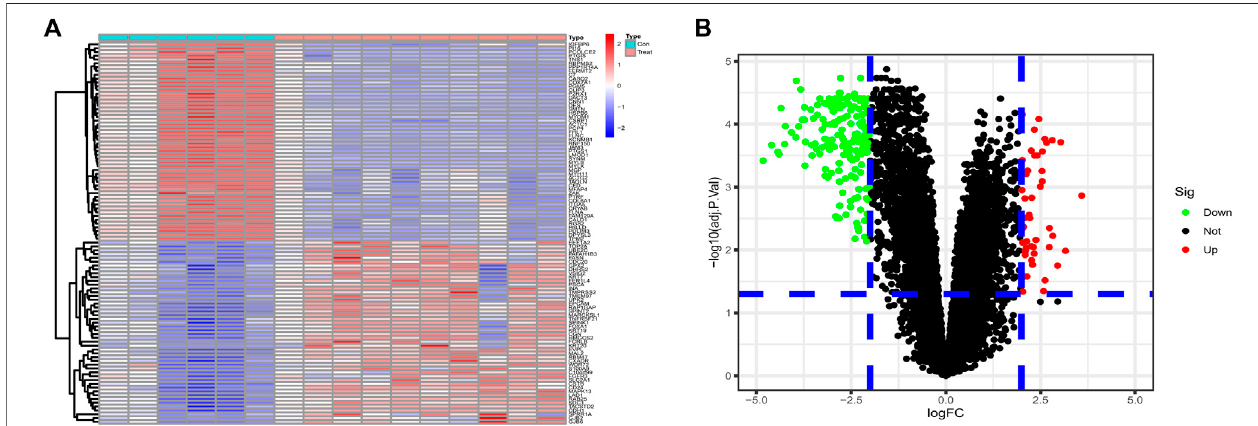
FIGURE1|(A) The50DEGsmostsigni fi cantlyupregulatedand50mostdownregulatedidenti fi edfromdatasetsGSE61615andGSE65635werevisualizedinthe form of a heatmap. (B) Based on the criteria logFC ≥ 2 or ≤ − 2 and p value < 0.05, 242 ponderable DEGs were fi ltered out and a volcano map was drawn.